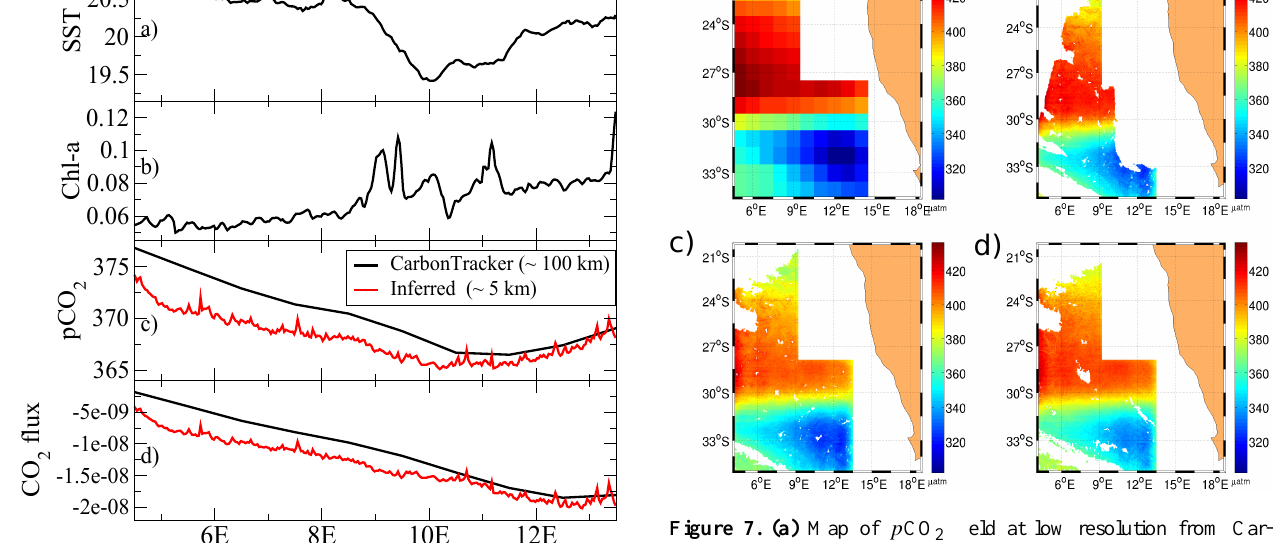
Figure 7. (a) Map of p CO 2 field at low resolution from Car- bonTracker. Reconstructed p CO 2 field at super resolution us- ing (b) OSTIA SST and MERIS Chl a , (c) OSTIA SST and GSM-GLOBCOLOUR Chl a and (d) MODIS SST and GSM- Figure 6. Longitudinal profiles of (a) SST from OSTIA products GLOBCOLOUR Chl a . All maps correspond to 21 Septem- in units of ◦ C, (b) Chl a from GLOBCOLOUR-GSM ocean in ber mgm − 3 , (c) p CO Ctrack (black line) and p CO infer (red line) in 2 2 µatm, and (d) air–sea CO 2 fluxes from CarbonTracker (black line) and inferred air–sea CO 2 fluxes (red line) in mol C m − 2 s − 1 . All these longitudinal profiles correspond to the fixed latitude equal to 33.5 ◦ S of the plots shown in Fig. 5 for 22 March 2006.